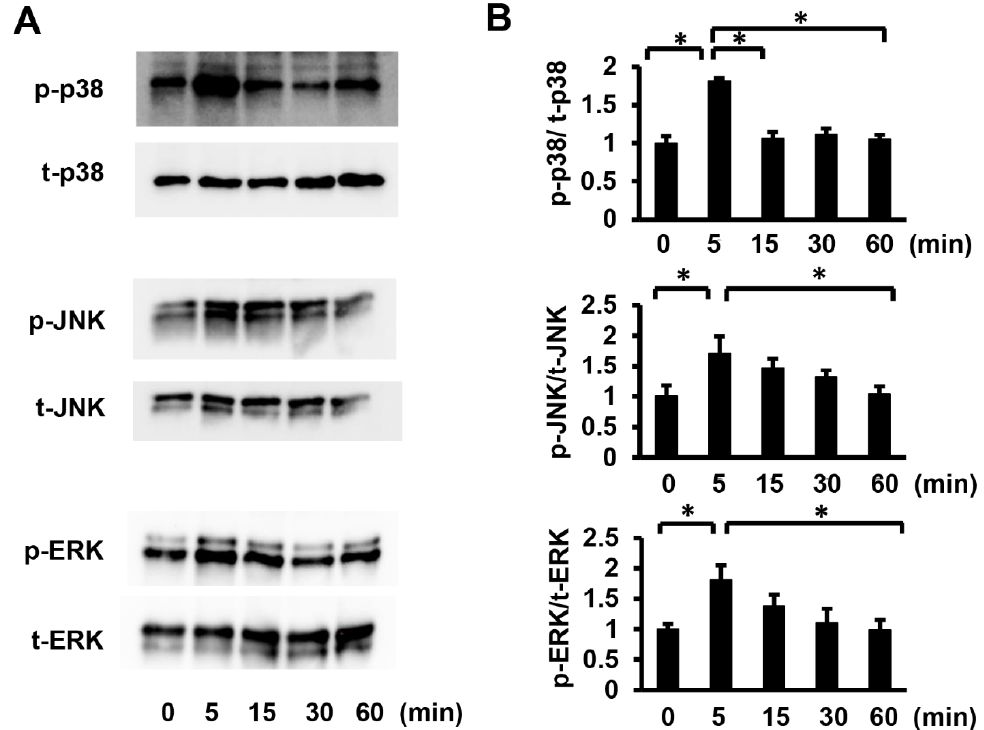
Figure 5. Pg -LPS stimulation increases the p38 MAPK, SAPK/JNK, and ERK phosphorylation levels in HASMCs. ( A ) Phosphorylation of p38 MAPK, SAPK/JNK, and ERK in HASMCs after Pg -LPS treatment. HASMCs were treated with Pg -LPS (100 ng/mL), and the p38 MAPK, SAPK/JNK, and ERK phosphorylation levels (P-p38, P-SAPK/JNK, and P-ERK, respectively) were determined by Western blot analysis. Representative blots are shown. ( B ) Quantitative analysis of the p38 MAPK, SAPK/JNK, and ERK phosphorylation levels with a peak at 5 min. n = 6 in each group. * p < 0.05 vs. basal. Data are presented as mean ± SE.